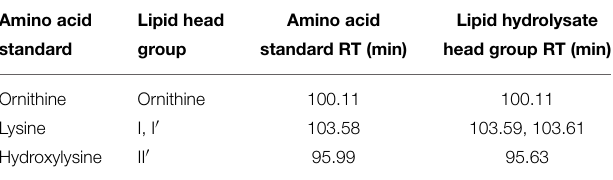
TABLE 3 | Amino acid analysis retention times (RT) of amino acids released from ornithine lipid, proposed lysine lipid (group I, LL), proposed lysine lipid with hydroxylated fatty acid (group I ′ , LL HFA ), and proposed hydroxylysine lipid with hydroxylated fatty acid (group II ′ , HLL HFA )